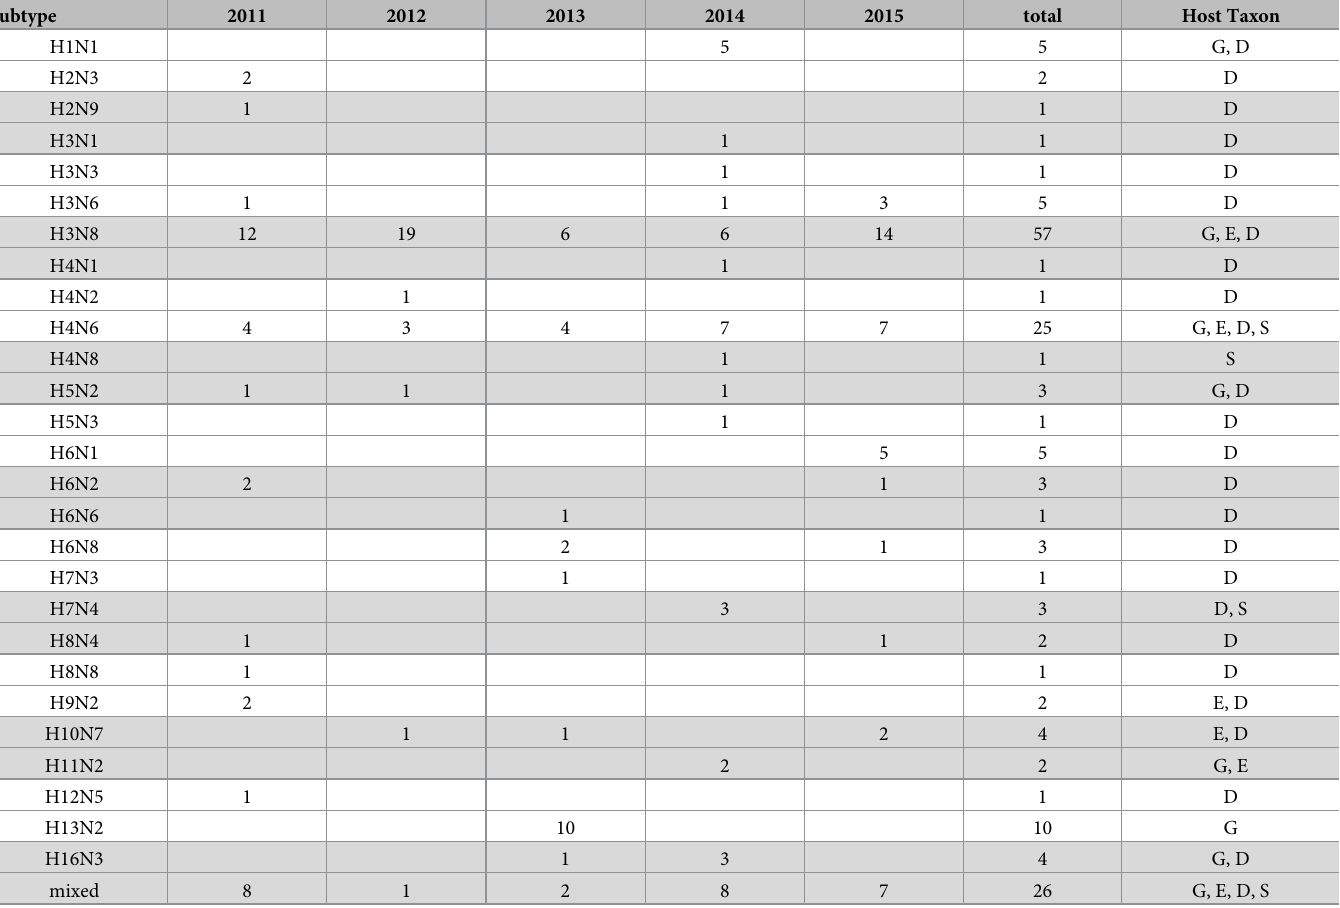
All isolates with more than one genetic sequence detected for one or more gene segment are reported here as “mixed” infection. D = dabbling duck ( Anas acuta , A . crecca , A . platyrhychos , and A . clypeata ; n = 135), E = emperor goose ( Chen canagica ; n = 13), G = glaucous-winged gull ( Larus glucescens ; n = 20), and S = sea duck (i.e. Bucephala albeola and Somateria spectabilis ; n =